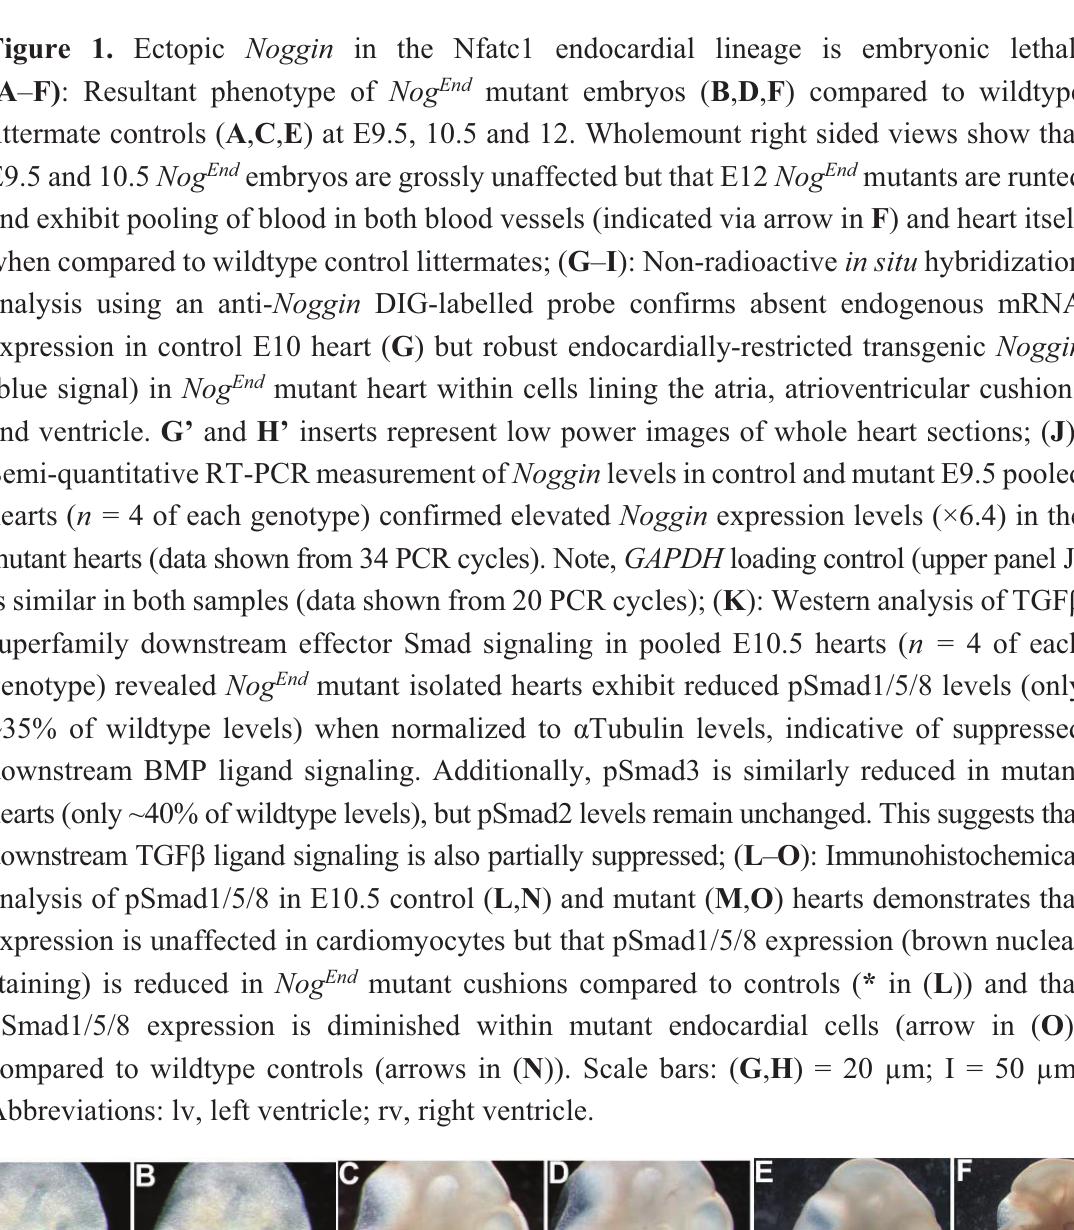
Figure 1. Ectopic Noggin in the Nfatc1 endocardial lineage is embryonic